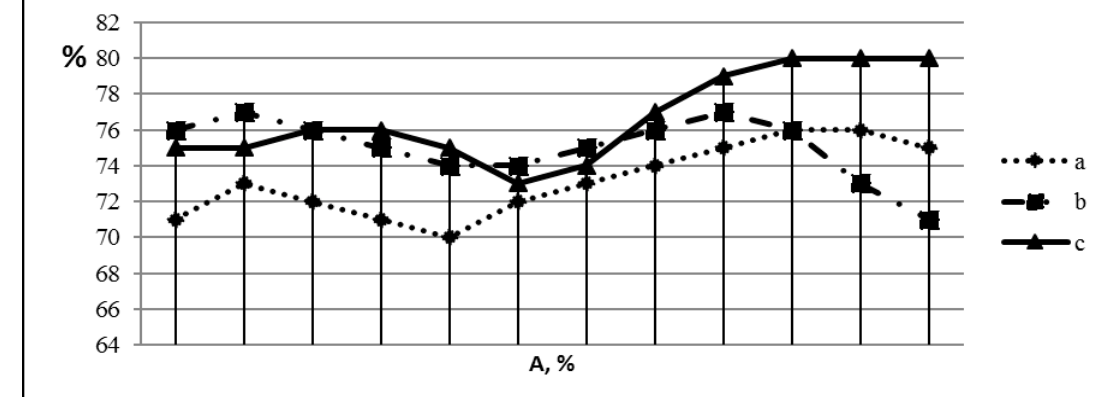
Fig. 3. Change of effectiveness of efforts ( % ) in elite cyclists in trainings of speed power ( a ), anaerobic ( b ) and aero- bic ( c ) orientation. A – Period of training.